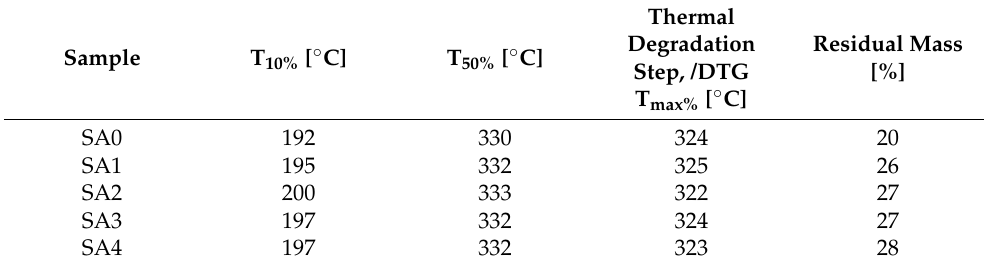
Table 2. Thermogravimetric properties of the obtained